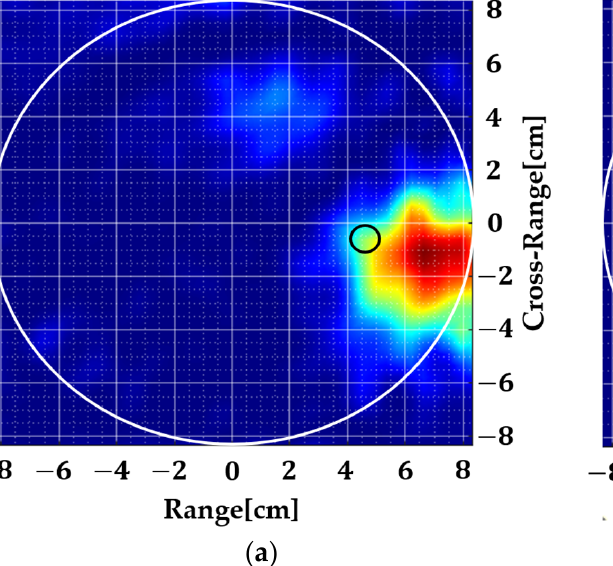
( b ) flour + 350 mL water (10%), ( c ) flour + 700 mL water (20%), and ( d ) antenna S 11 in three cases.